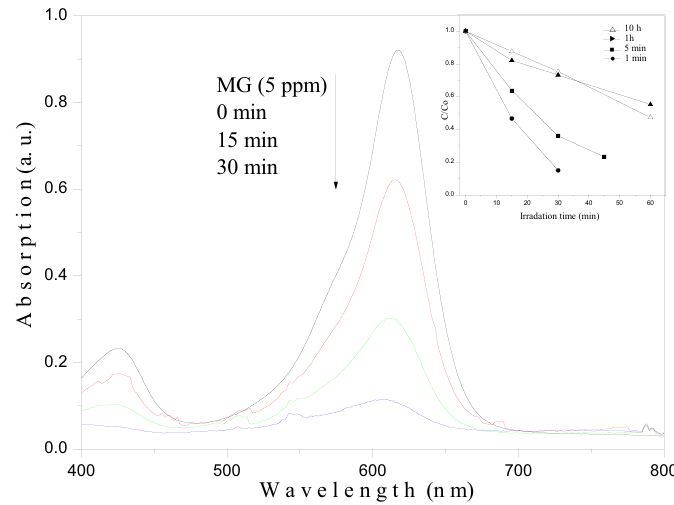
Figure 6. Absorption changes of Malachite Green (MG) solution on ZnO powder mechanically activated at 500 rpm (1 min), the inside shows the rate of degradation of MG on ZnO powder mechanically activated at 500 rpm after different milling time.